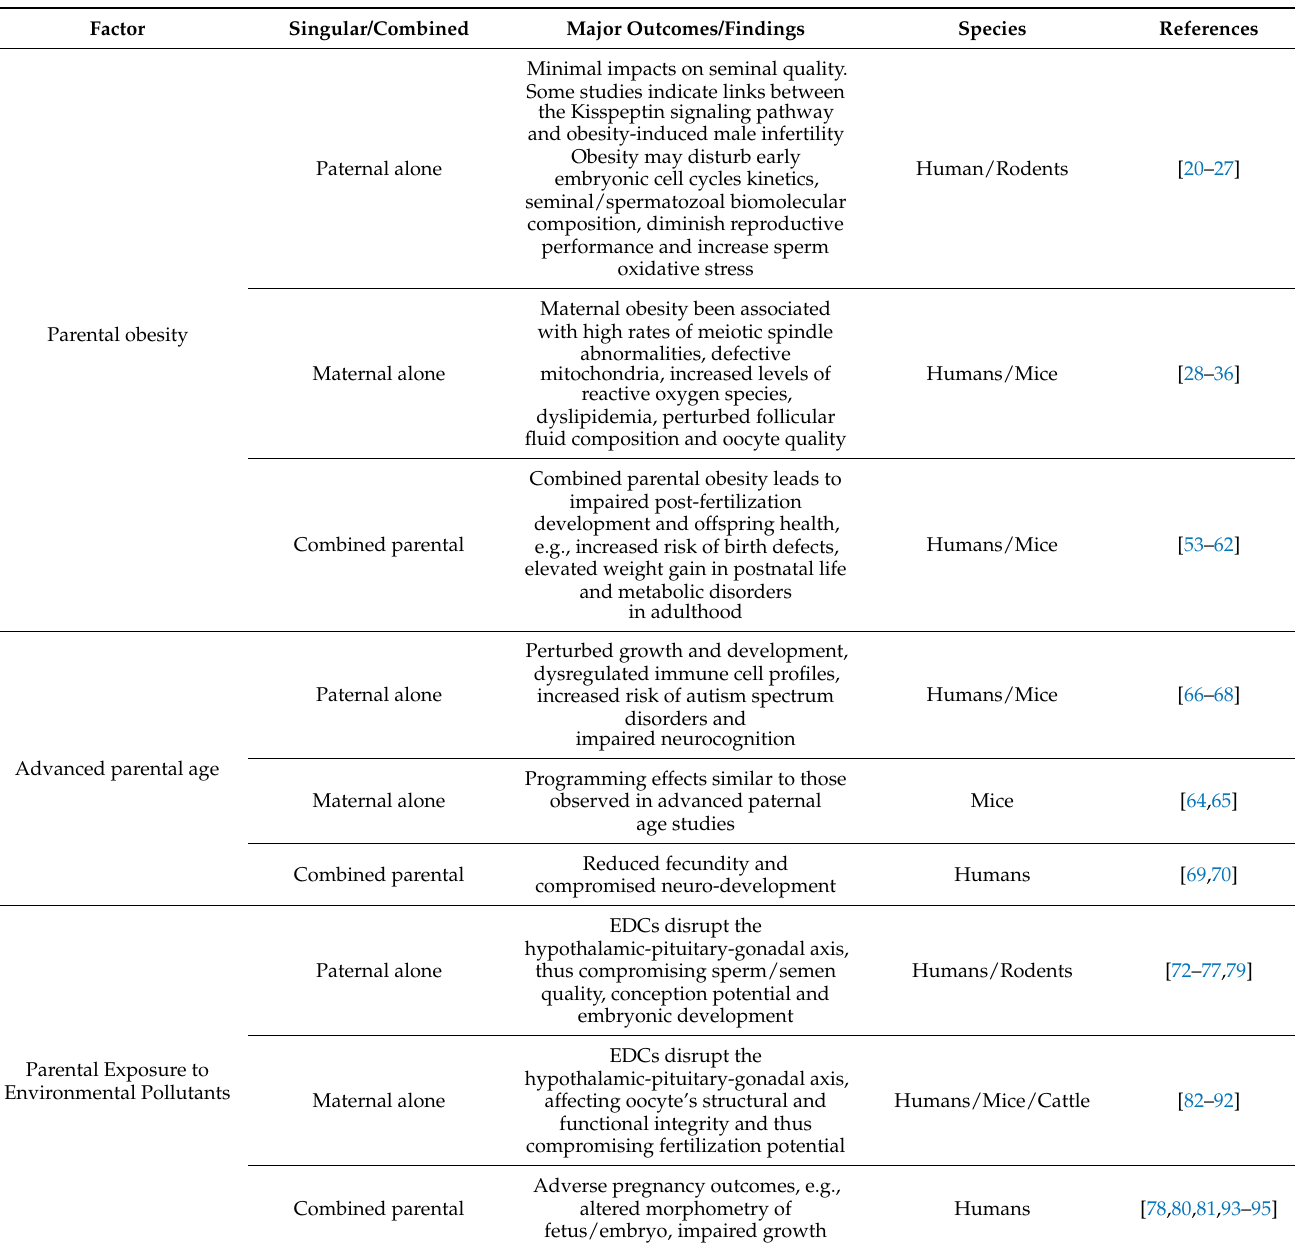
Table 1. Summary of studies that found altered fetal/offspring outcomes in response to singular (maternal or paternal) or combined parental